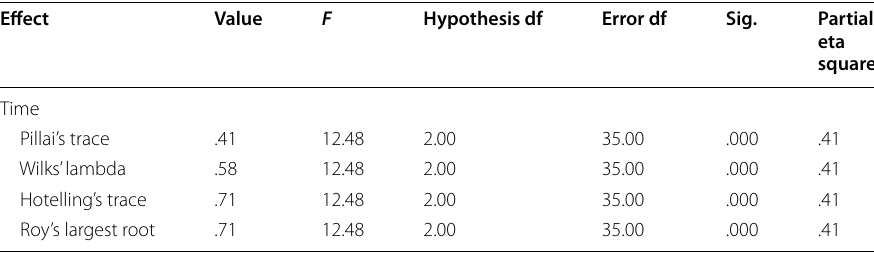
Table 7 Multivariate tests